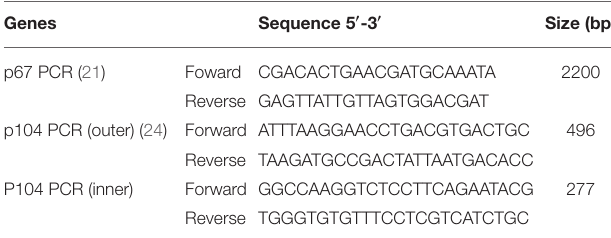
TABLE 1 | Primers used to detect T. parva genes p67 and